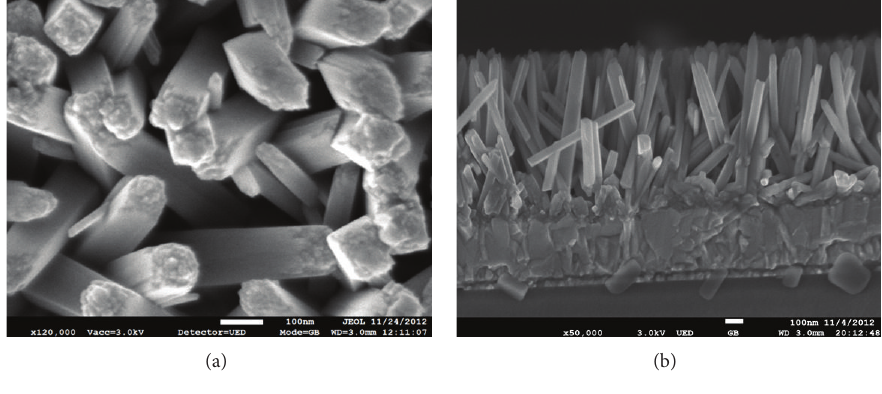
Figure 1: Nanorod-array structure TiO 2